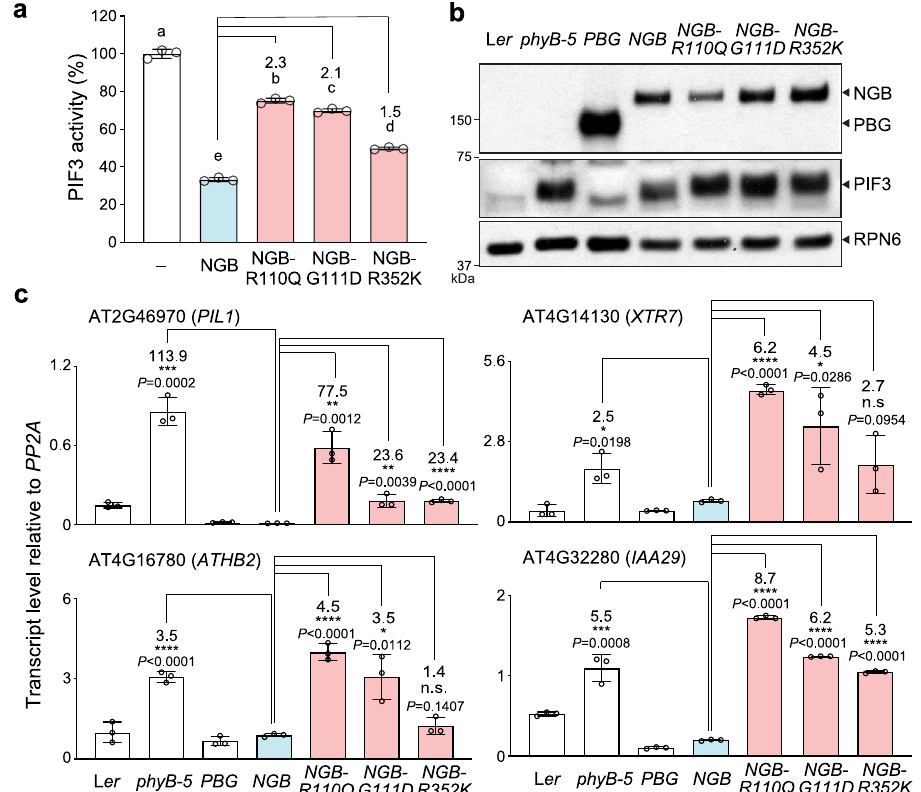
Fig. 8 NGB inhibits PIF3 activity via light-sensing knot. a Results of yeast liquid β -galactosidase assays showing the activity of PIF3 expressed alone (-) or coexpressed with NGB or NGB mutants. The transactivation activities were calculated relative to that of the yeast strains expressing PIF3 alone. Samples labeled with different letters exhibited statistically signi fi cant differences in transactivation activity (ANOVA, Tukey ’ s HSD, P < 0.05, n = 3). The numbers represent fold-changes between the NGB mutants and NGB. Error bars represent the s.d. of three biological replicates. The centers of the error bars represent the mean values. b Immunoblots showing the steady-state levels of PBG, NGB, and PIF3 in 4-d-old L er , phyB-5 , PBG , NGB , NGB-R110Q , NGB-G111D , and NGB-R352K seedlings grown in 10 μ mol m − 2 s − 1 R light. PBG and NGB were detected using anti-GFP antibodies, and PIF3 was detected using anti-PIF3 antibodies. RPN6 was used as a loading control. The immunoblot experiments were independently repeated at least three times, and the results of one representative experiment are shown. c qRT-PCR results showing the steady-state transcript levels of PIF3 target genes, PIL1 , XTR7 , ATHB2 , and IAA29 , in the lines described in ( b ). The transcript levels were calculated relative to those of PP2A . The numbers indicate fold changes relative to NGB ; the statistical signi fi cance was analyzed using two-tailed Student ’ s t -test (* P ≤ 0.05, ** P ≤ 0.01, *** P ≤ 0.001, **** P ≤ 0.0001). Error bars represent the s.d. of three biological replicates. The centers of the error bars represent the mean values. The source data underlying the yeast liquid β -galactosidase assays in ( a ), the immunoblots in ( b ), and the qRT-PCR data in ( c ) are provided in the Source data fi